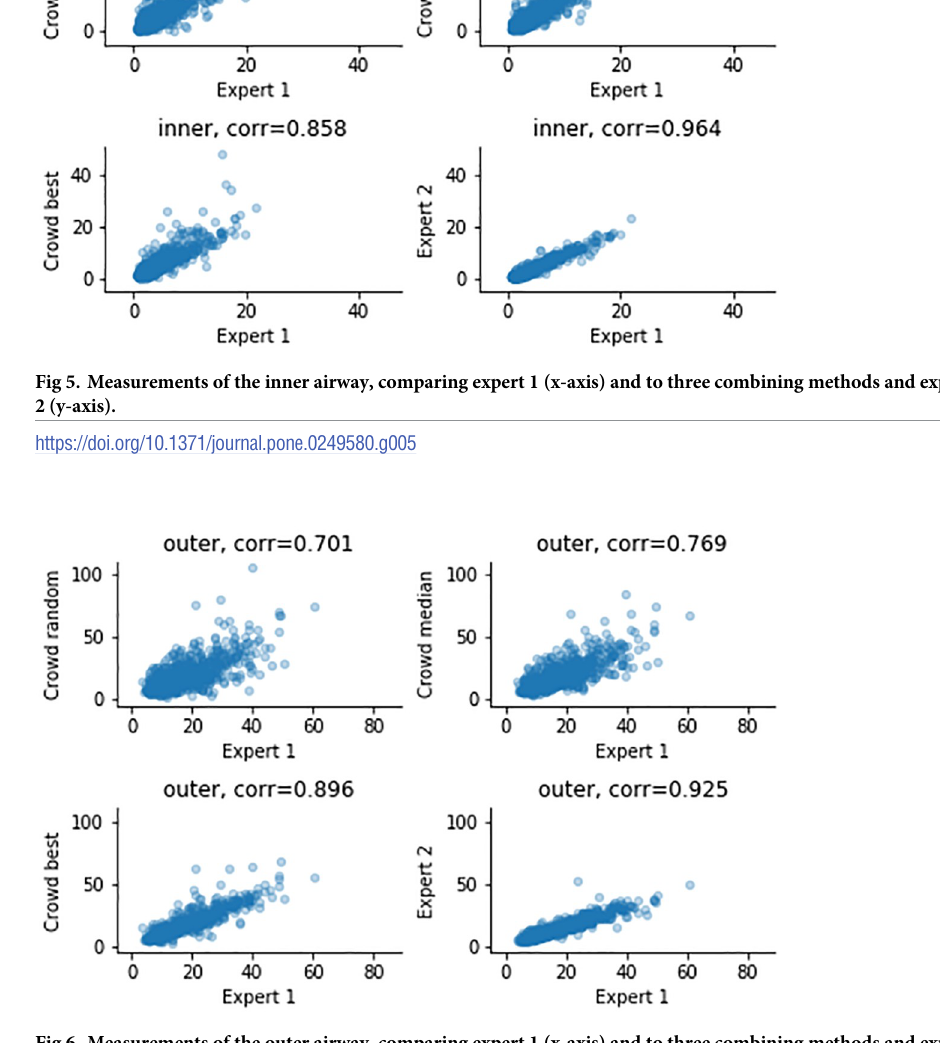
PLOS ONE | https://doi.org/10.1371/journal.pone.0249580 April 22,